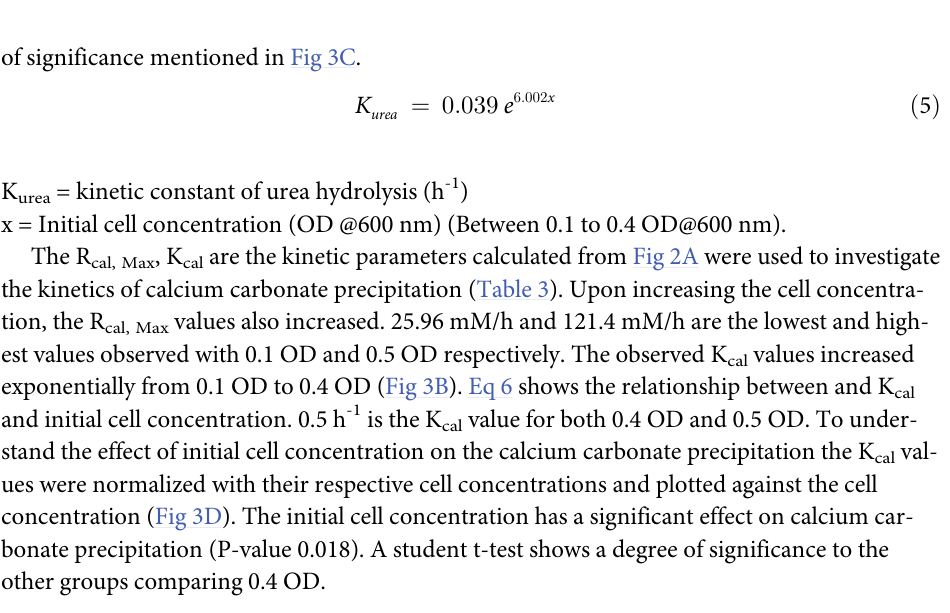
Fig 3. The influence of cell concentration on the urea hydrolysis and CaCO 3 precipitation. The exponential relationship between kinetic constant of urea hydrolysis (K urea ) and cell concentration (A), The exponential relationship between kinetic constant of calcium carbonate precipitation (K cal ) and initial cell concentration (B), The effect of initial cell concentration on the kinetics of urea hydrolysis (C) and calcium carbonate precipitation (D). �� indicates P-value � 0.01, � indicates P-value � 0.05.